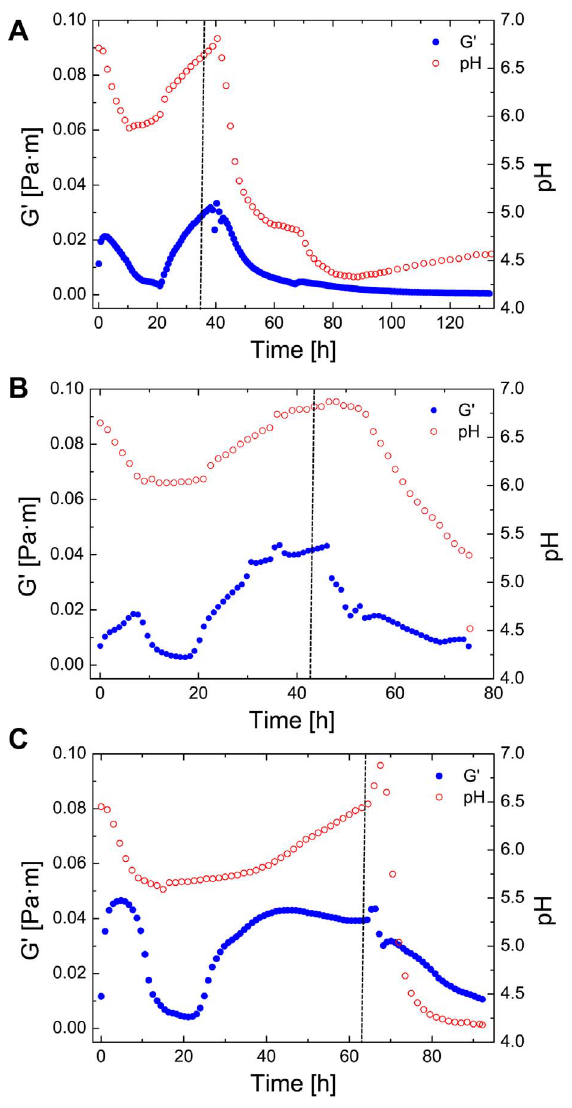
Figure 7. Effect of varying pH on biofilm elasticity after biofilm formation. The elasticity (G0) is plotted against the time of E. coli (A), P. fluorescens (B) and B. subtilis (C) before and after pH change. After the dotted line, the pH was controlled by the addition of 1 M